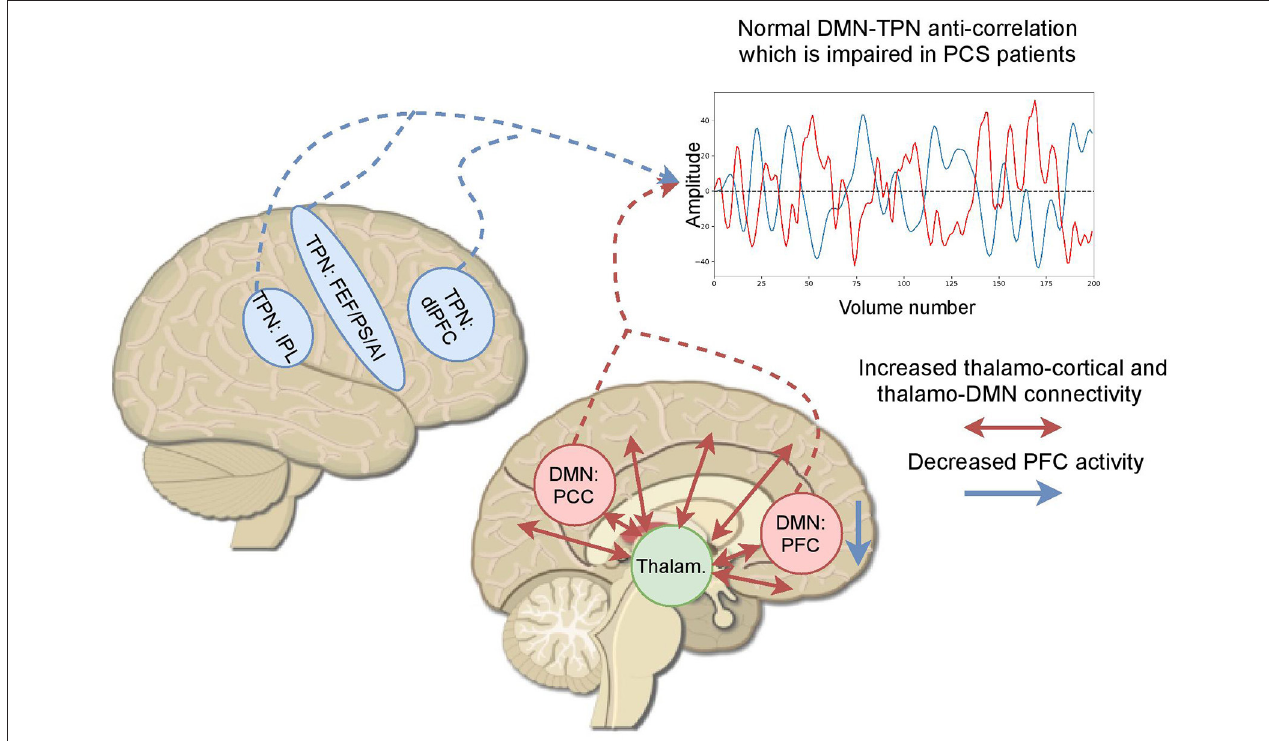
FIGURE 3 | Based on the fMRI studies exploring post-concussive symptoms (PCS), the main findings can be summarized as the abnormal increase of thalamo-cortical connectivity, alterations in the anticorrelation of the default mode network and the task positive network, and a reduction of the activity in the prefrontal cortex. A time series shows a created example of a normal DMN–TPN anticorrelation which becomes altered in patients with PCS. AI, anterior insula; dlPFC, dorsolateral prefrontal cortex; DMN, default mode network; FEF, frontal eye fields; IPL, inferior parietal lobe; PCC, posterior cingulate cortex; PFC, prefrontal cortex; PS, precentral sulcus; TPN, task-positive